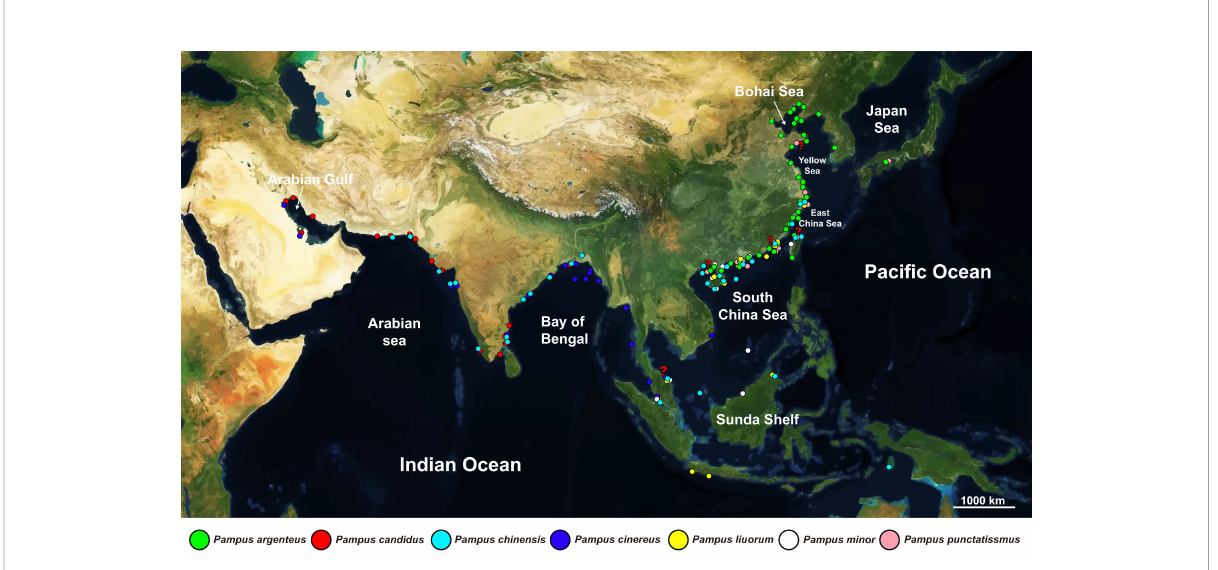
FIGURE 3 Distributions of the Pampus species based on sampling localities of the eight mitochondrial datasets used in this study. The basic map is generated in Mapbox (https://www.mapbox.com/). Spots on map denote sampling localities of the seven valid species. Geographically close localities are merged into one spot. Red question marks denote that Pampus candidus might not distribute in these sampling